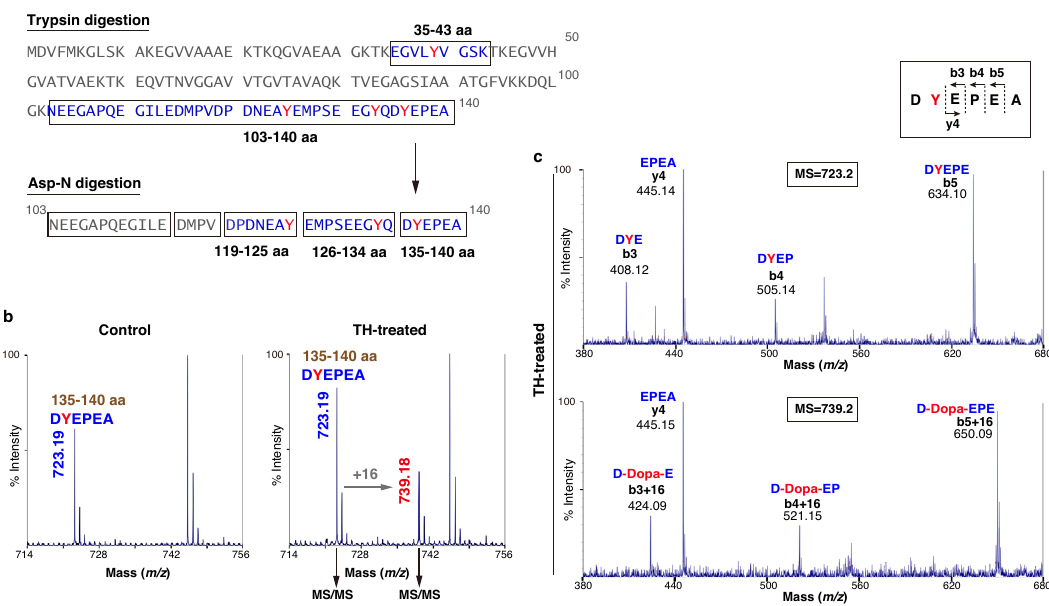
Fig. 1 | Hydroxylation of α Syn at the Tyr136 residue by TH treatment. a Digestionprocessof α Synbytrypsin(upper)andAsp-N(lower).Trypsindigestion yielded two tyrosine (red)-containing fragments (blue), whose sequences were boxed. A fragment of residues 103 – 140 of α Syn (103 – 140 aa) was further digested by Asp-N, yielding fi ve fragments, as shown by the boxed sequences. Here, Asp-N atypically cleaves the N-terminus of Glu126 but fails at N-terminus of Asp121. b MALDI-TOF mass spectrum of the fragment corresponding to 135 – 140 aa. The peak at m/z 723.19 corresponds to 135 – 140 aa (control, left). After TH treatment